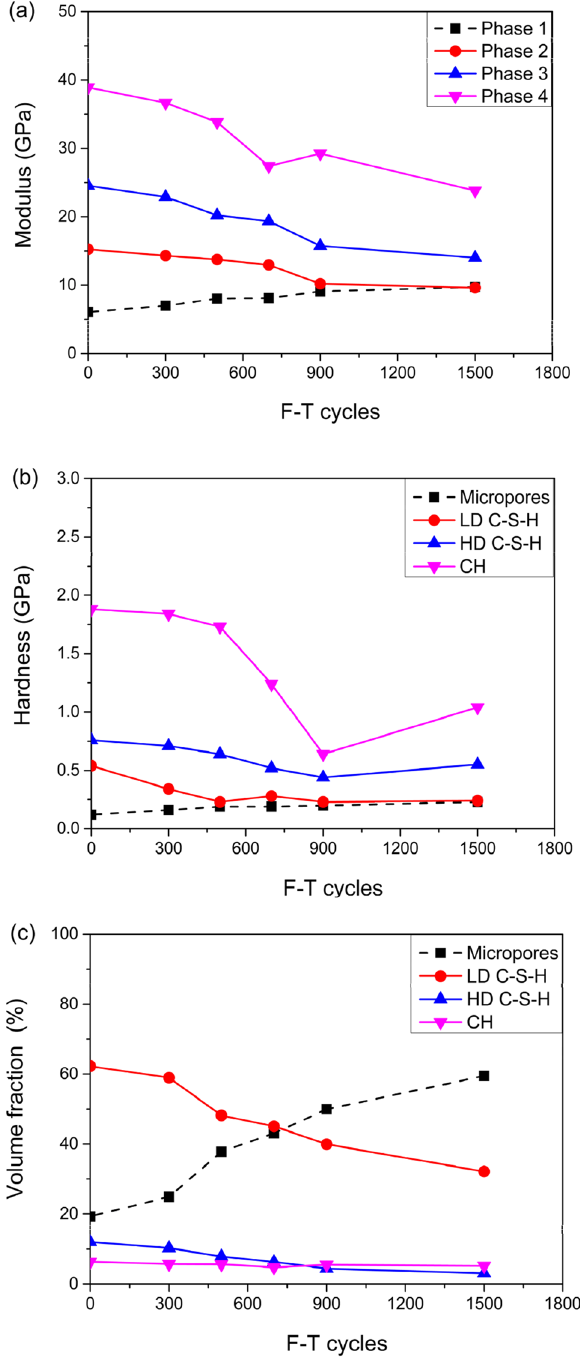
Figure 10. The deconvolution results of